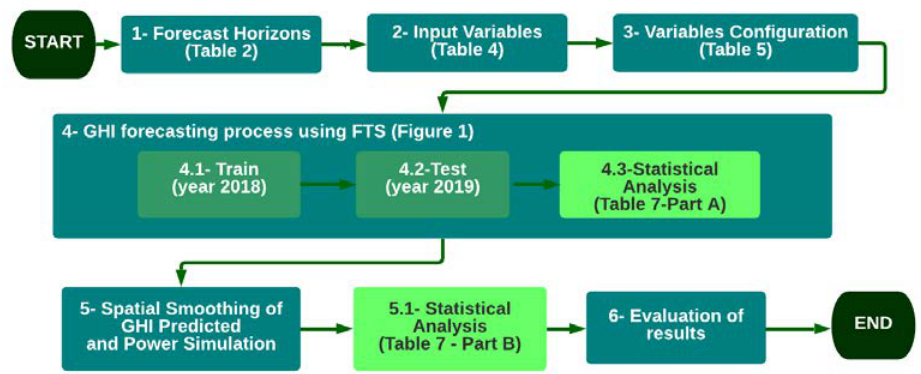
Figure 2. Algorithm of the irradiance forecasting method and subsequent power simulation of this work. this work.